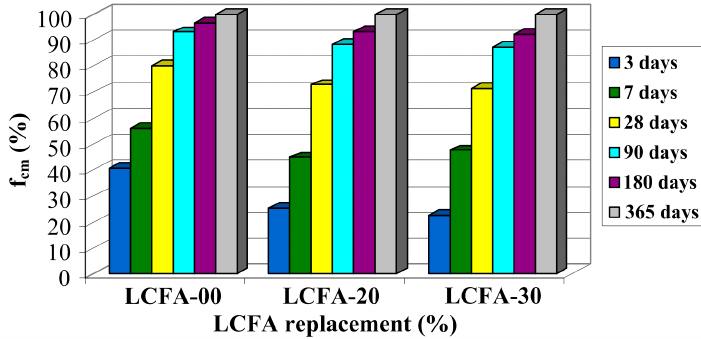
Figure 13. Relative changes of compressive strengths over time.